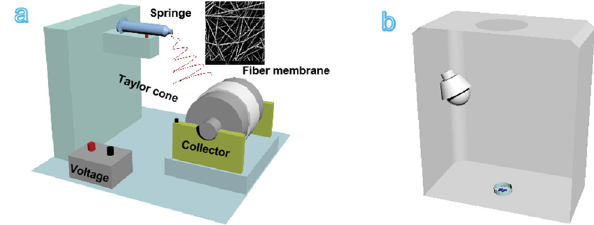
Figure 2: The schematic of electrospinning ( a ) and the photo - graphing equipment of MIM - BCM and NIM - BCP ( b )